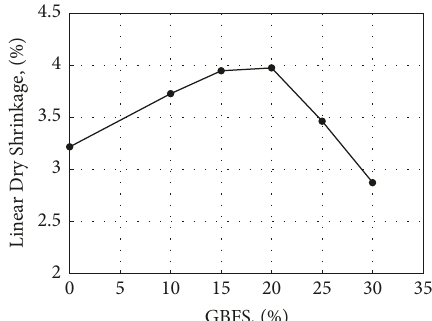
Figure 4: Effect of GBFS addition on Linear Drying Shrinkage.